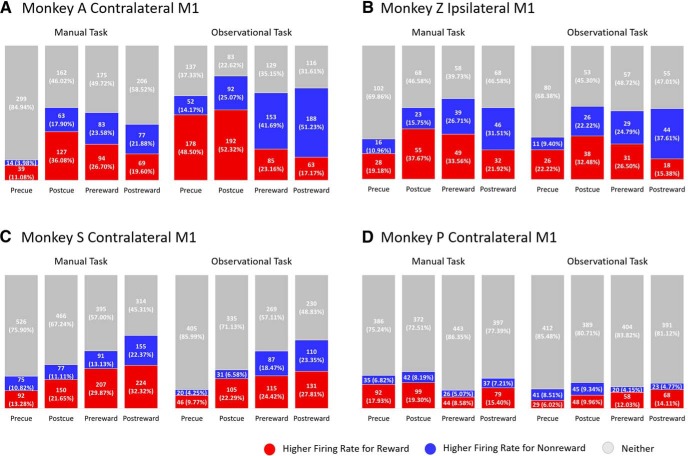
Total population of M1 units that had significantly higher FRs for rewarding (red), nonrewarding (blue) trials, or neither (gray) across manual (left column) and observational (right column) tasks for contralateral (A, C, D) and ipsilateral (B) M1 cortices (Wilcoxon signed-rank test, p < 0.05). Each column in the bar chart represents precue (500 ms), postcue (800 ms), prereward (500 ms), and postreward (500 ms) periods. A, B are for the center-out reaching tasks, and C, D are for the grip force tasks.